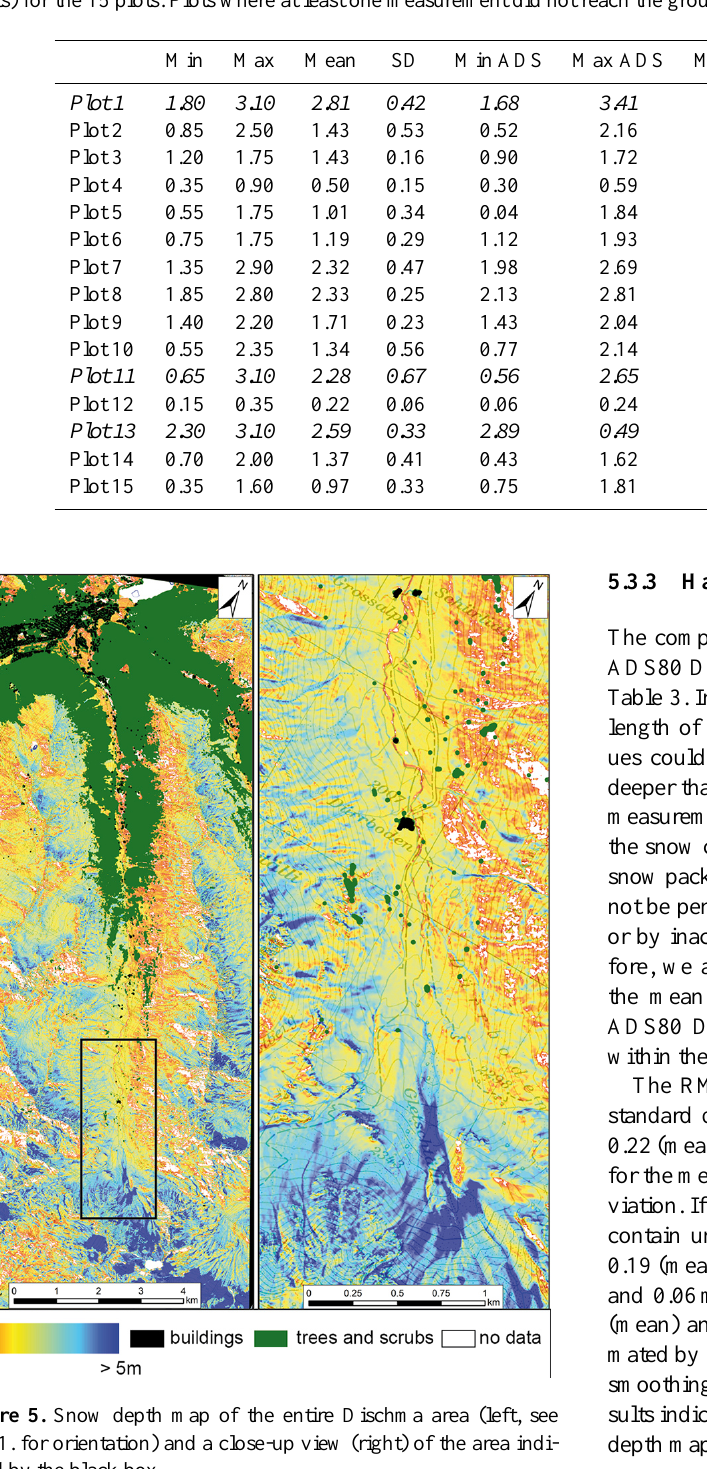
Table 3. ADS80 DSM-derived snow depth values (4 × 4 pixels) compared to the hand-measured snow depth values (5 × 5 single measure- ments) for the 15 plots. Plots where at least one measurement did not reach the ground are displayed in italic.